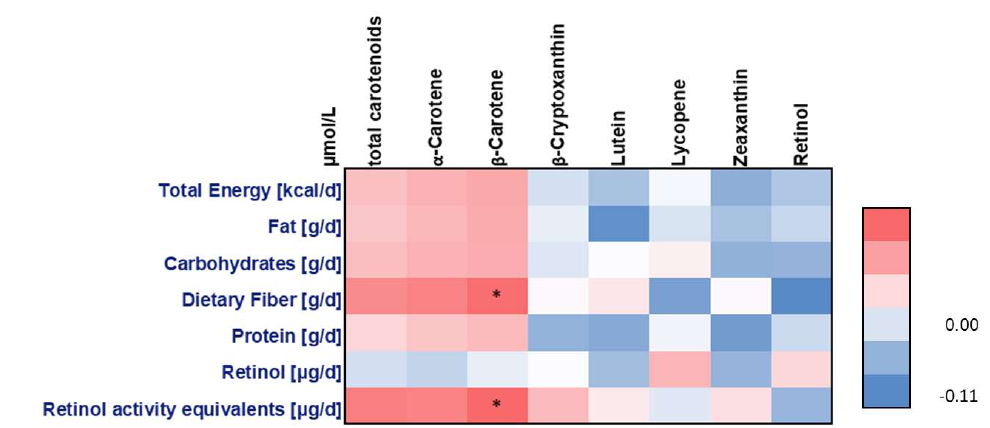
Figure 1. Spearman correlations of calculated food frequency questionnaire-derived nutrient intakes with plasma carotenoid and retinol concentrations; * p < 0.05.